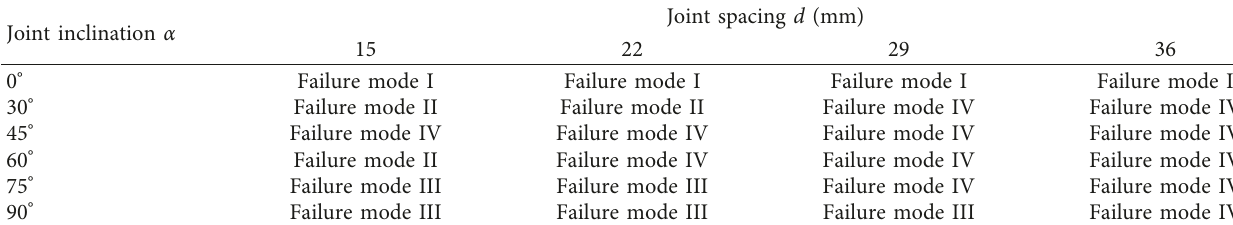
Table 2: Failure modes for specimens with the different joint inclination and joint